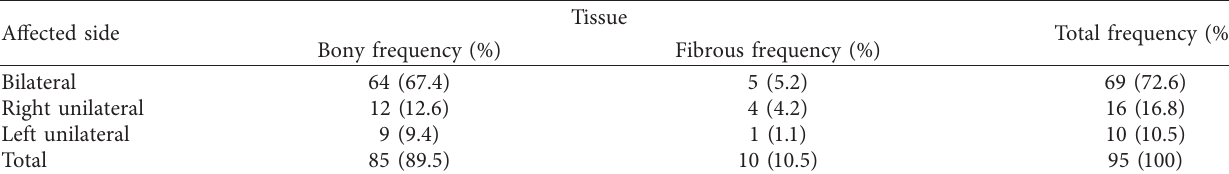
Table 3: Frequency distribution of TMJA classes based on the affected side and tissue